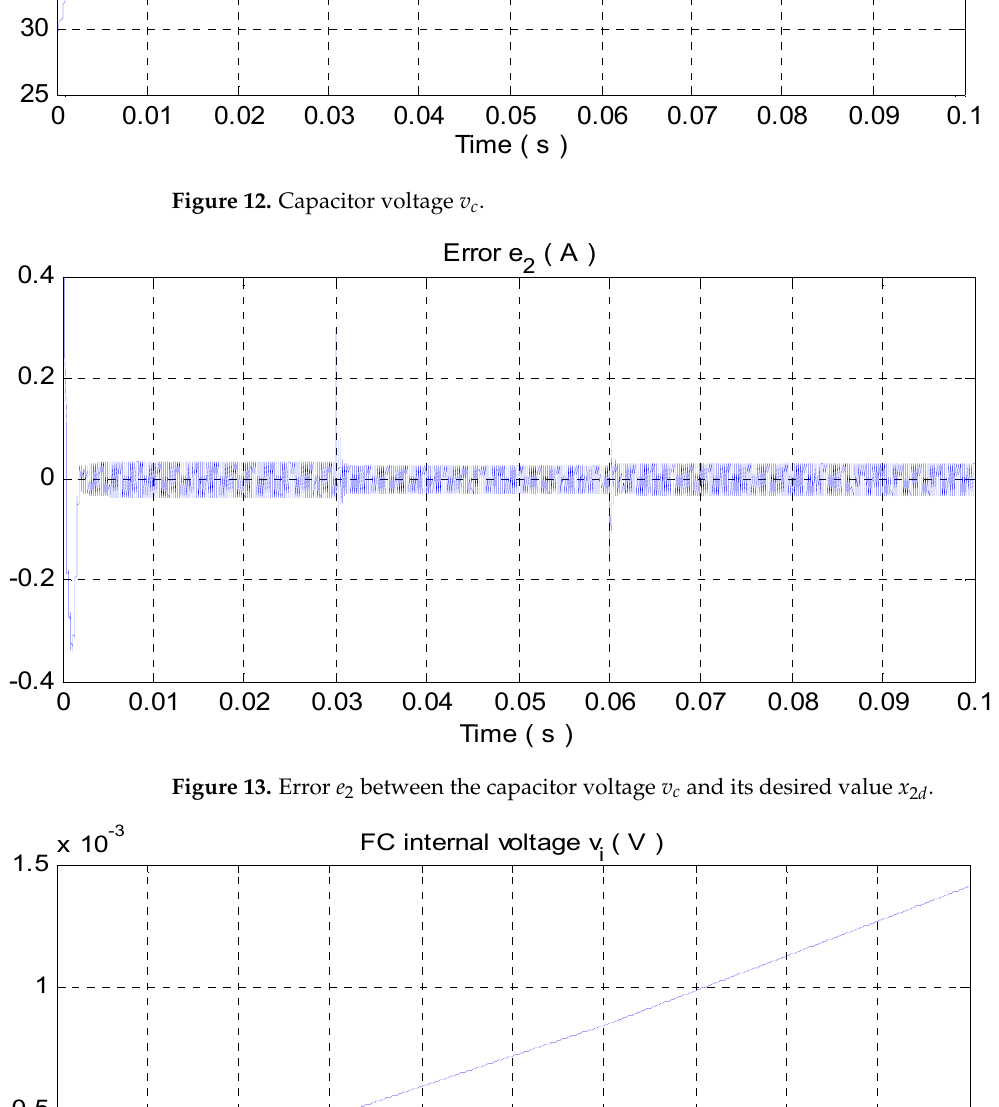
Figure 14. FC internal voltage v i .